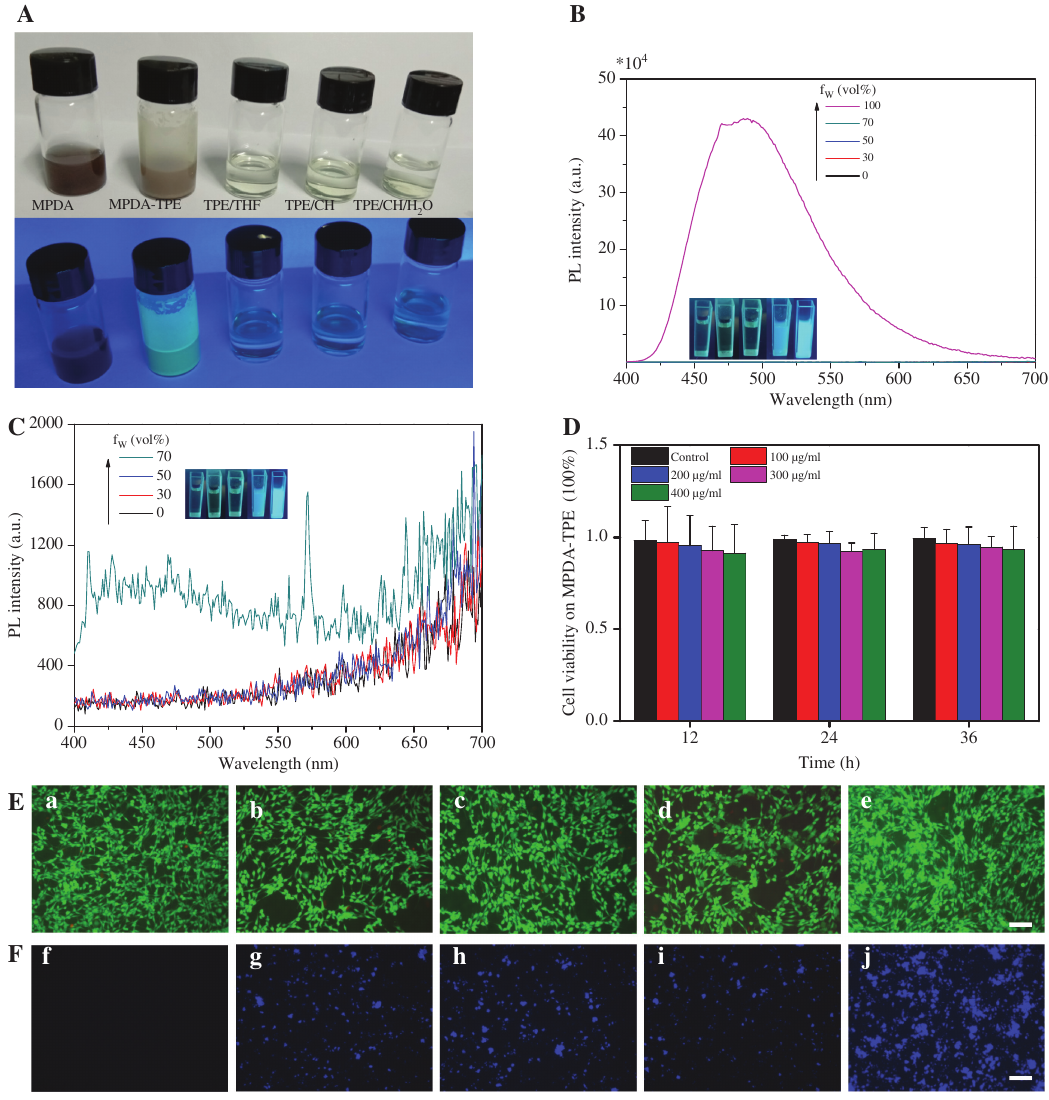
Figure 3: Characterization of optical, biocompatibility, and bioimaging properties of MPDA-TPE. (A) Color of MPDA-TPE in different solvent with or without excitation of UV light. PL spectra of (B, C) MPDA-TPE in THF/water mixtures with different water fractions. (D) Cell viability of NIH-3T3 cells after incubation with different concentrations MPDA-TPE for 12, 24, and 36 h. (E) Live/dead assay was used to evaluate cell survival on day 2 after incubation with different content of MPDA-TPE. (a) 0, (b) 100, (c) 200, (d) 300, and (e) 400 g/ml. (F) fluorescence imaging of NIH-3T3 cells treated with different content of MPDA-TPE. (f) 0, (g) 100, (h) 200, (i) 300, and (j) 400 g/ml. The scale bars indicate 100 μ